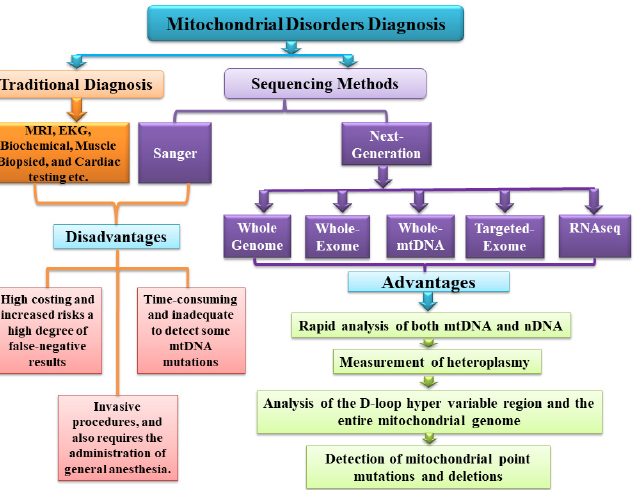
Figure 1. Diagrammatic representations of traditional and next-generation sequencing for identifying mitochondrial disorders.